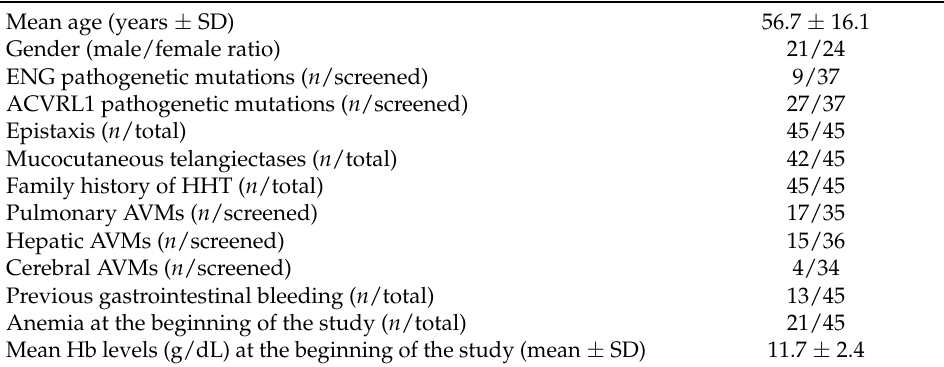
Table 1. Characteristics of the study population ( n = 45).